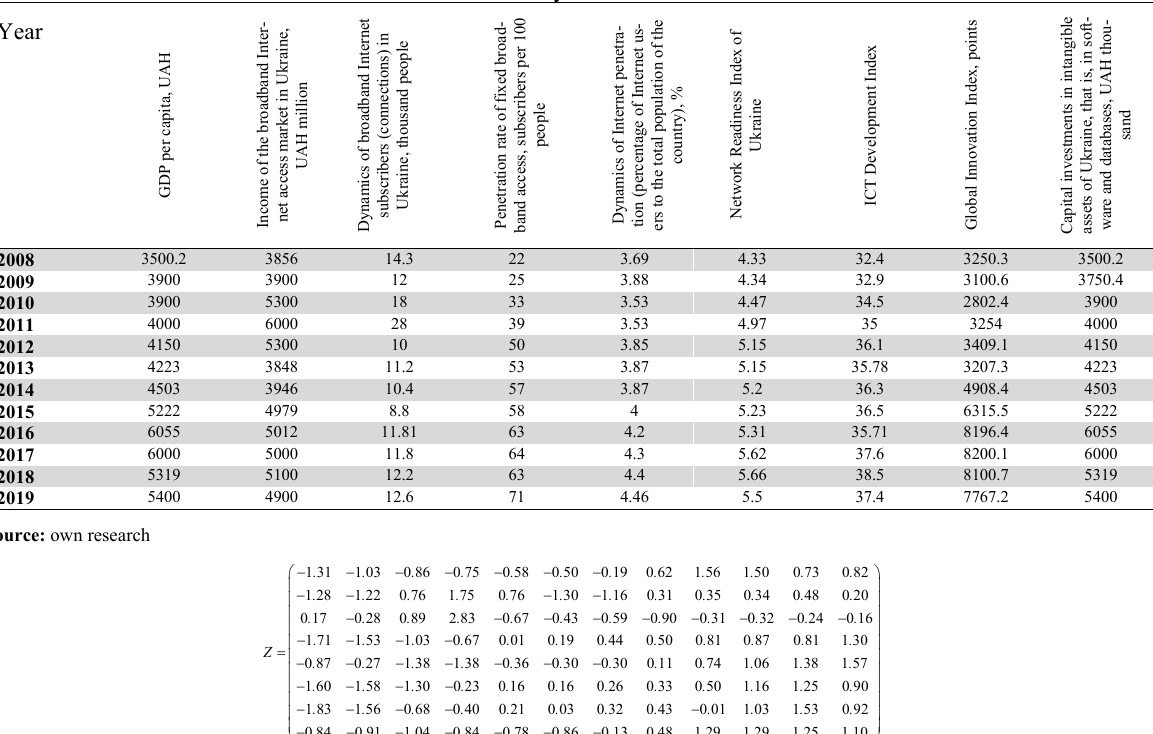
The main indicators that characterize the information security of Ukraine